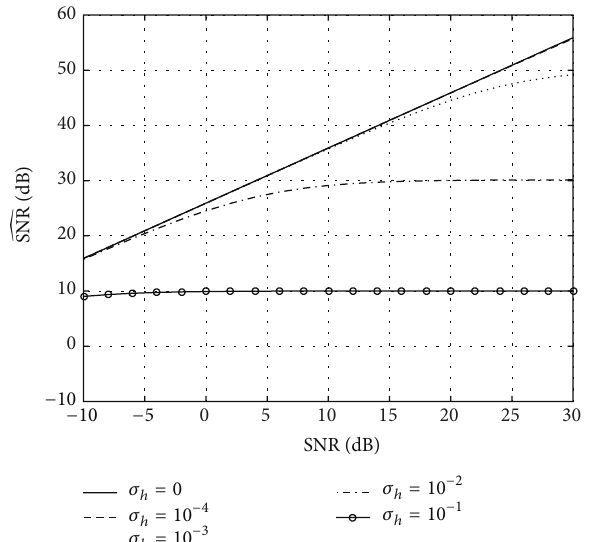
̂ SNR ( dB ) ) as a function of